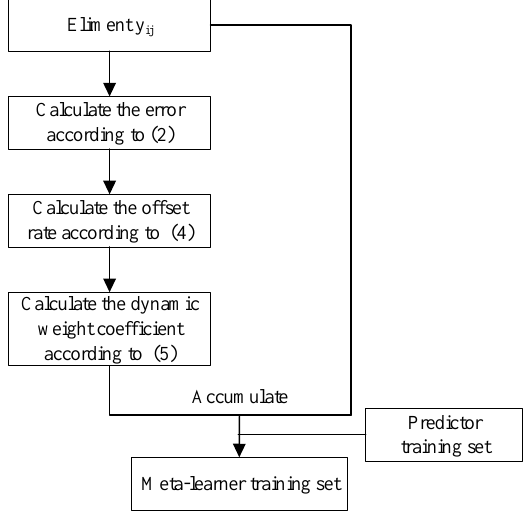
Figure 5. The meta learner training set adjustment process.